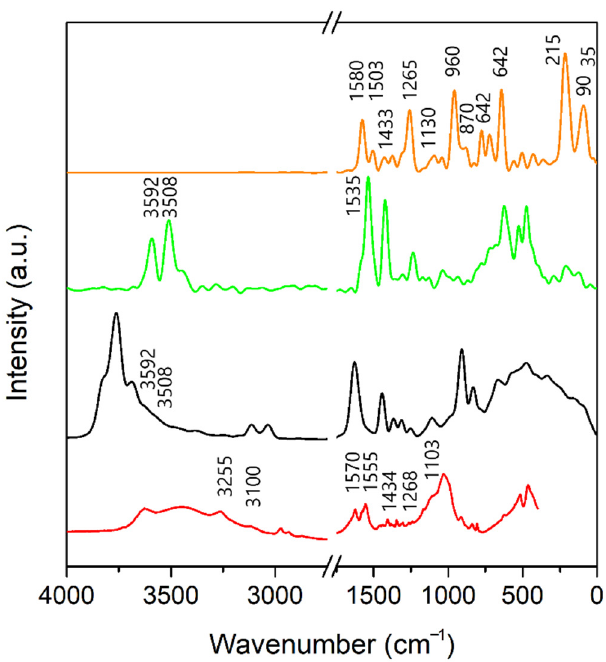
Figure 4. The experimental (red) and calculated total VDOS (black), the projected VDOS of the -NH groups (green) and the projected VDOS of the triazine ring (orange) for the A-Mt model.